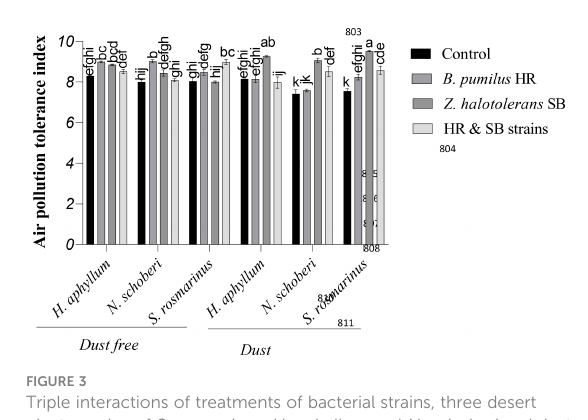
FIGURE 3 Triple interactions of treatments of bacterial strains, three desert plant species of S. rosmarinus , H. aphyllum and N. schoberi and dust on air pollution tolerance index (APTI) of three plant species grown under greenhouse conditions for fi ve months. Alphabets indicate signi fi cant differences among various treatments (Means ± SE, n = 3) according to Tukey ’ s multiple-range test at p